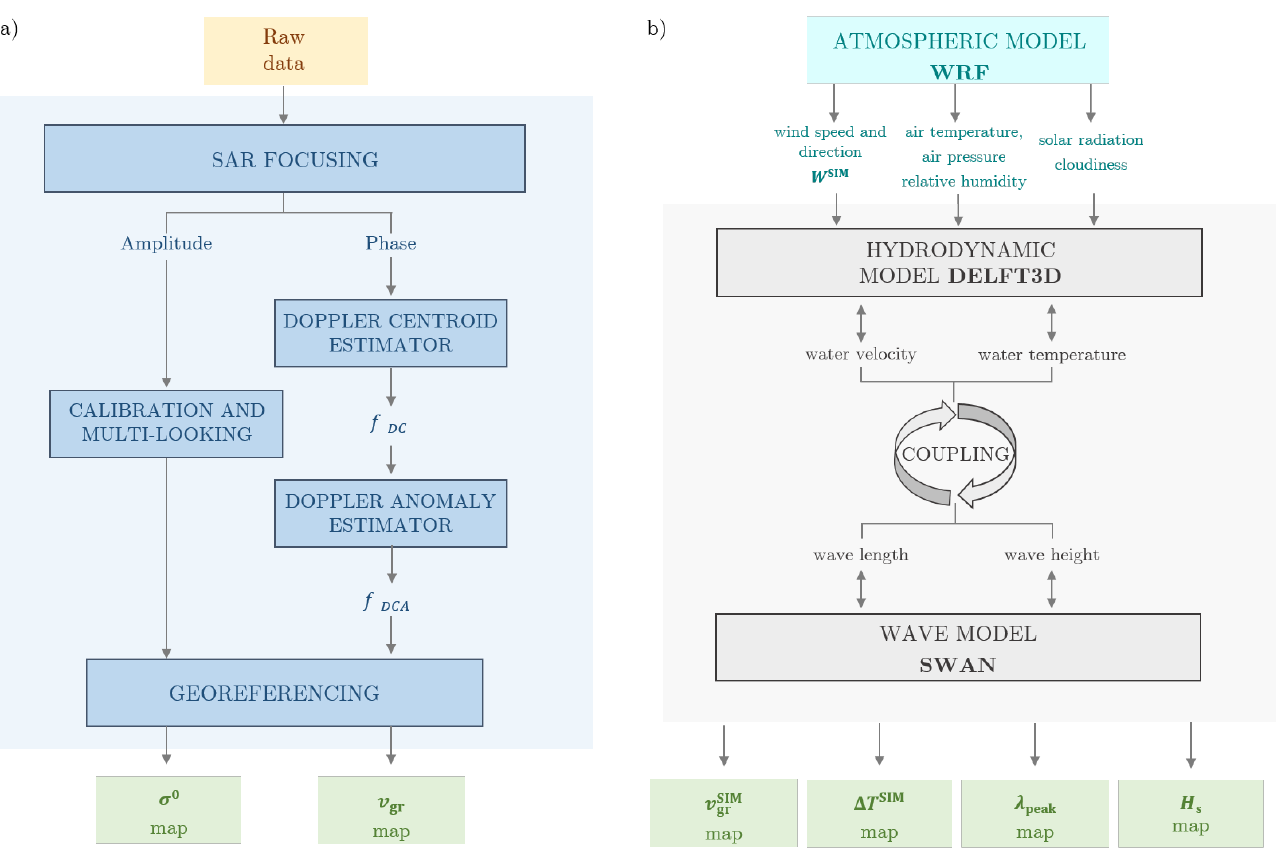
Figure 2. ( a ) Procedure for the generation of v gr and σ 0 maps from SAR data; ( b ) modeling chain for the simulation of surface water velocity, temperature and waves